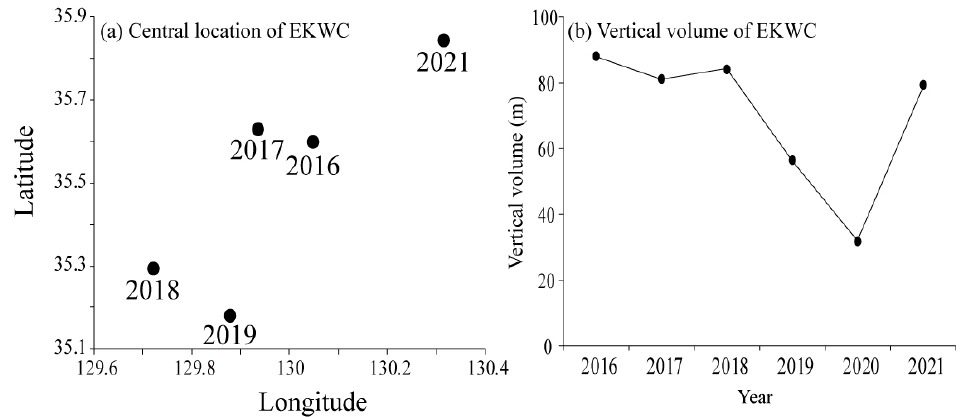
Figure 7. Inter-annual changes in ( a ) central location and ( b ) vertical volume of East Korea Warm Current (EKWC).